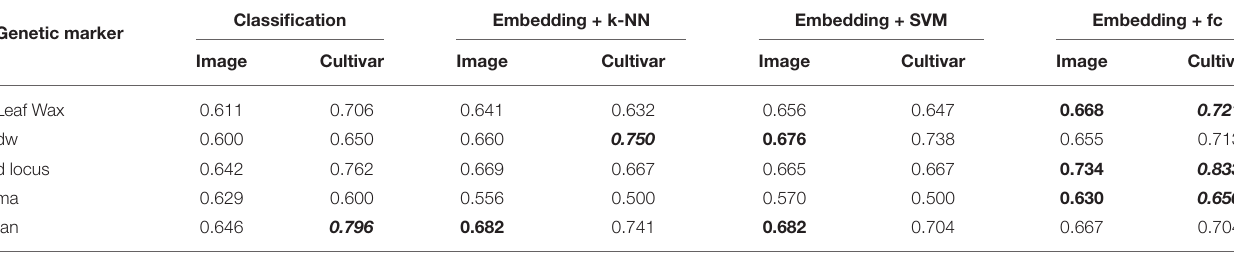
TABLE 3 | Classification accuracy by image and by cultivar. Genetic marker